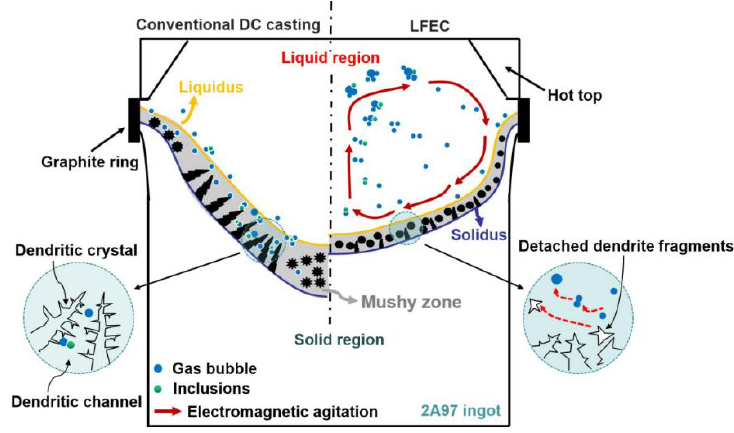
Figure 13. Schematic diagrams of the solidification.